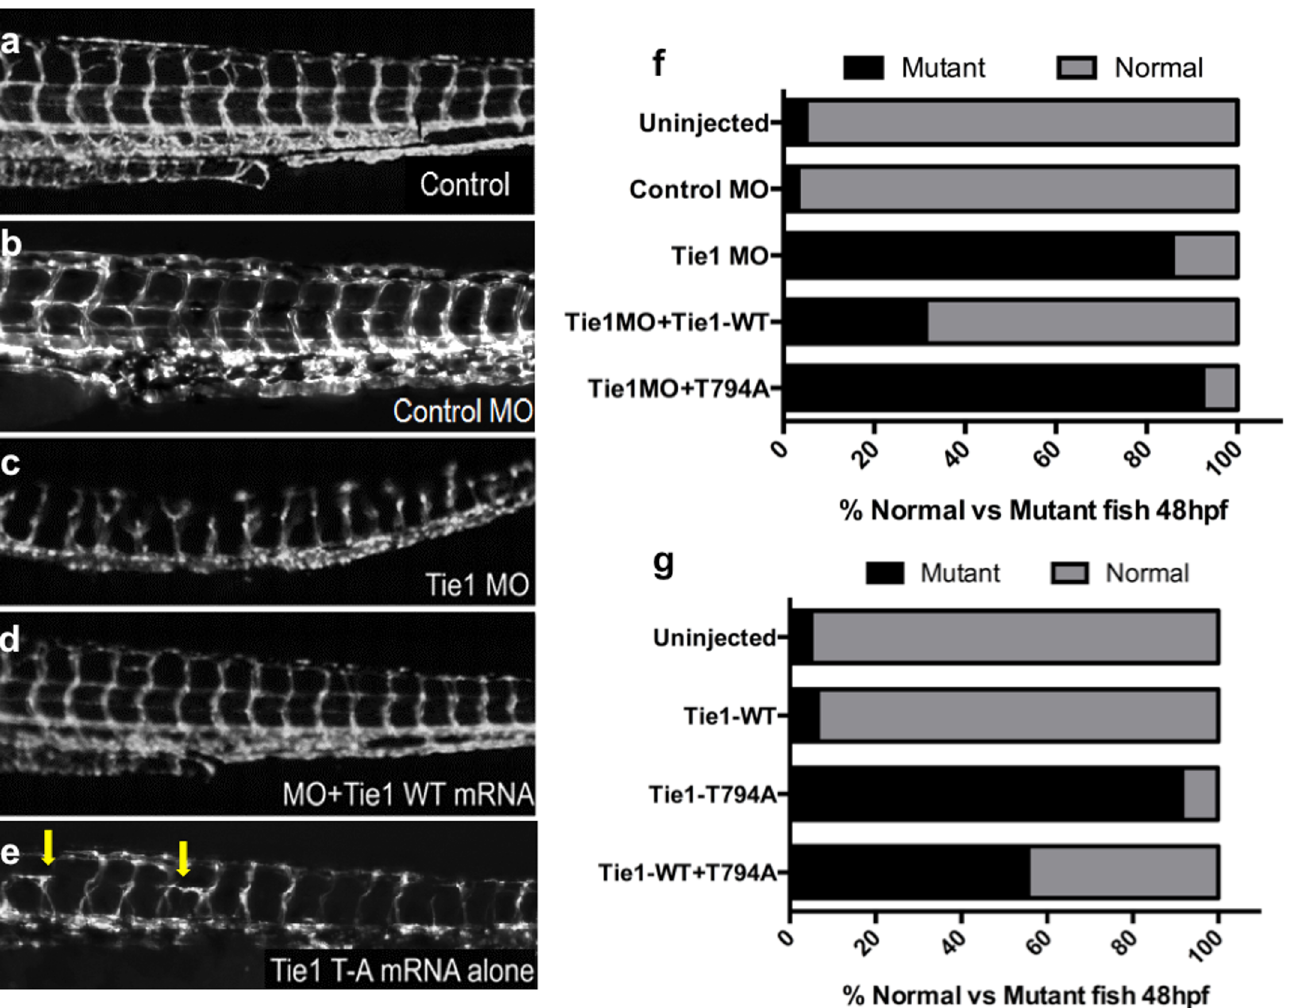
Fig 2. Tie1 and Thr794 are required for proper embryonic vascular development in zebrafish. a-e Zebrafish embryos expressing Fli1:EGFP were injected with a control or Tie1 morpholino (MO) with or without mRNA encoding WT or T794A (TA) mutant Tie1 and effects on vascular development were assessed. b Zebrafish injected with a control MO develop normally and resemble uninjected (Control) embryos. c Tie1 MO-injected embryos display vascular abnormalities. d Co-injection of Tie1 MO and WT mouse Tie1 mRNA rescued the MO phenotype. e Injection of T794A mutant mouse Tie1 mRNA alone resulted in vascular abnormalities similar to those of MO-injected embryos. Arrows indicate blunted intersomitic vessel formation. f Quantification of mutant embryos after injection of Tie1 MO with WT or T794A mutant mRNA, P = 3.0x10 -19 by Chi squared analysis. g Quantification of mutant embryos after injection of Tie1-WT or -TA mRNA alone, P = 1.3x10 -18 by Chi squared